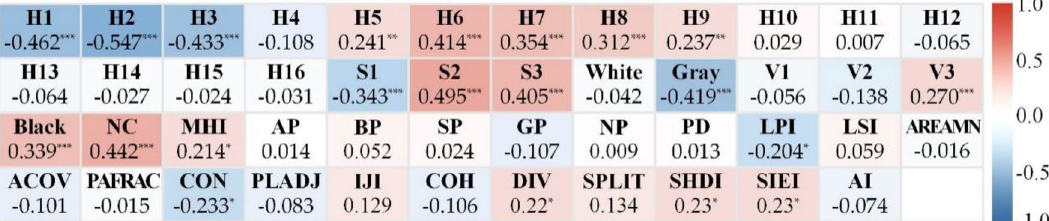
Figure 6. Results of the correlations between SBE values and color indices. * p < 0.05, ** p < 0.01, *** p < 0.001. NC number of colors, MHI maximum hue proportion index; See Fig. 5 for definitions of H, S, and V and Table 1 for the remaining